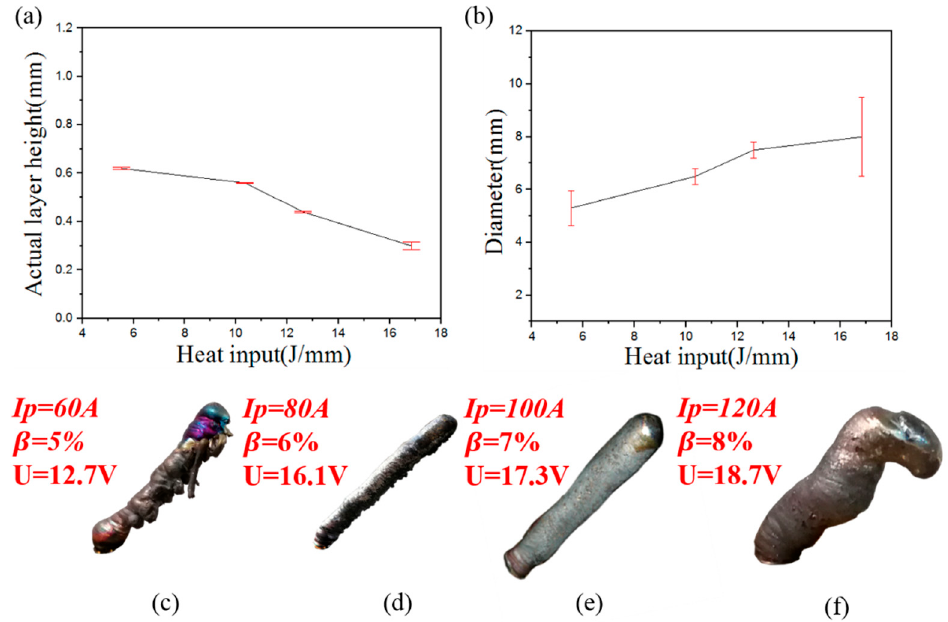
Figure 11. ( a ) Relationship between heat input and actual layer size; ( b ) Relationship between heat input and diameter; ( c ) Typical sample morphology in group I; ( d ) Typical sample morphology in group II; ( e ) Typical sample morphology in group III; ( f ) Typical sample morphology in group IV .